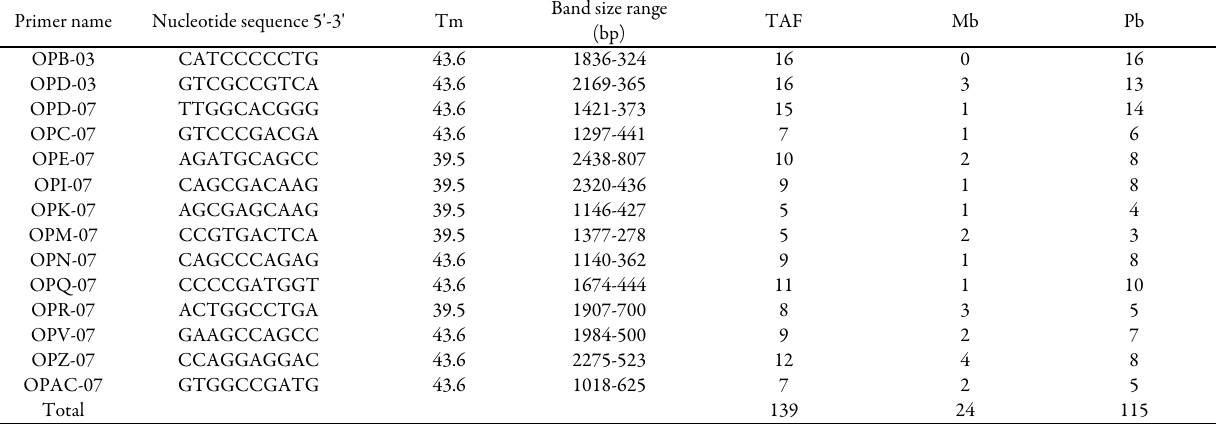
Table 2. RAPD analysis of wild plant and in vitro regenerated plants (SE= Somatic embryogenesis, D= Direct regeneration and ID= Indirect regeneration).TAF= Total amplified fragments, Mb= Monomorphic bands, Pb= Polymorphic bands